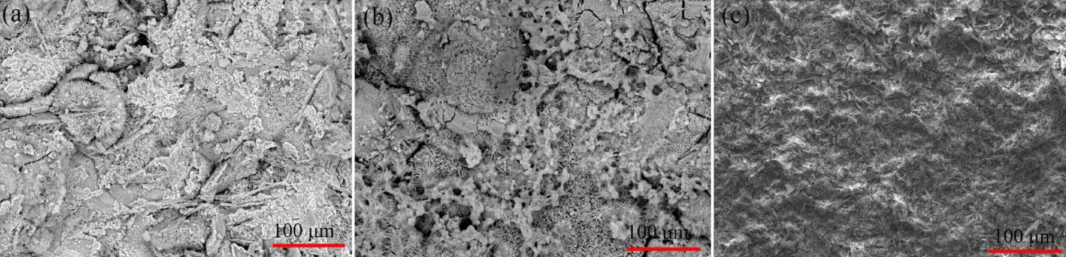
Figure 14. Morphologies of the CaPh-coated samples after 120 h immersion in SBF at 37 ± 0.5 ◦ C. ( a ) HT-C; ( b ) AT-C; ( c )